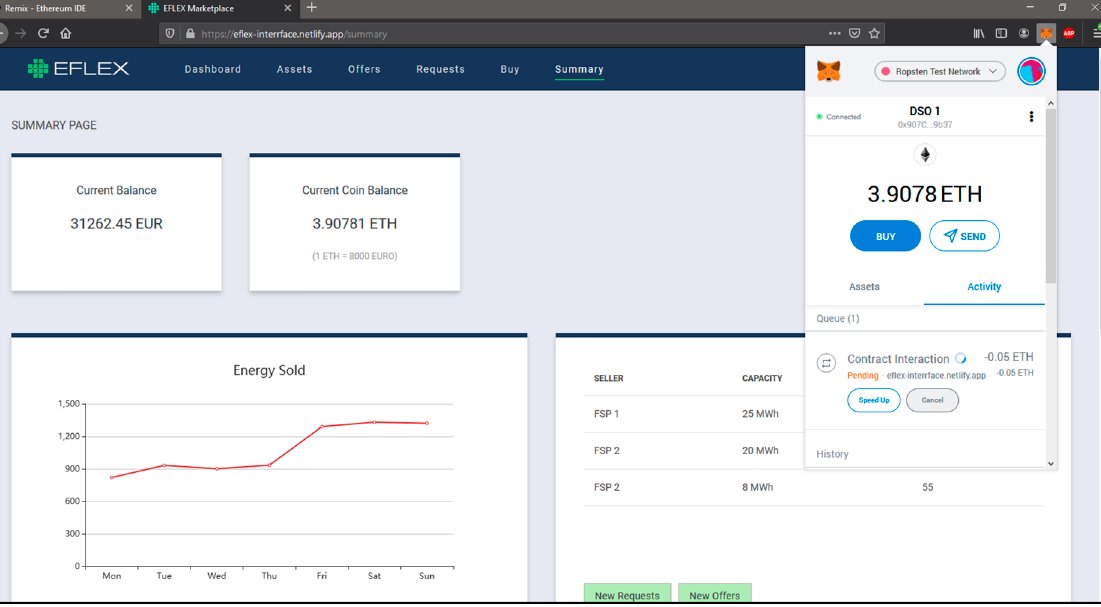
Figure 23. Overview of transactions, balance.